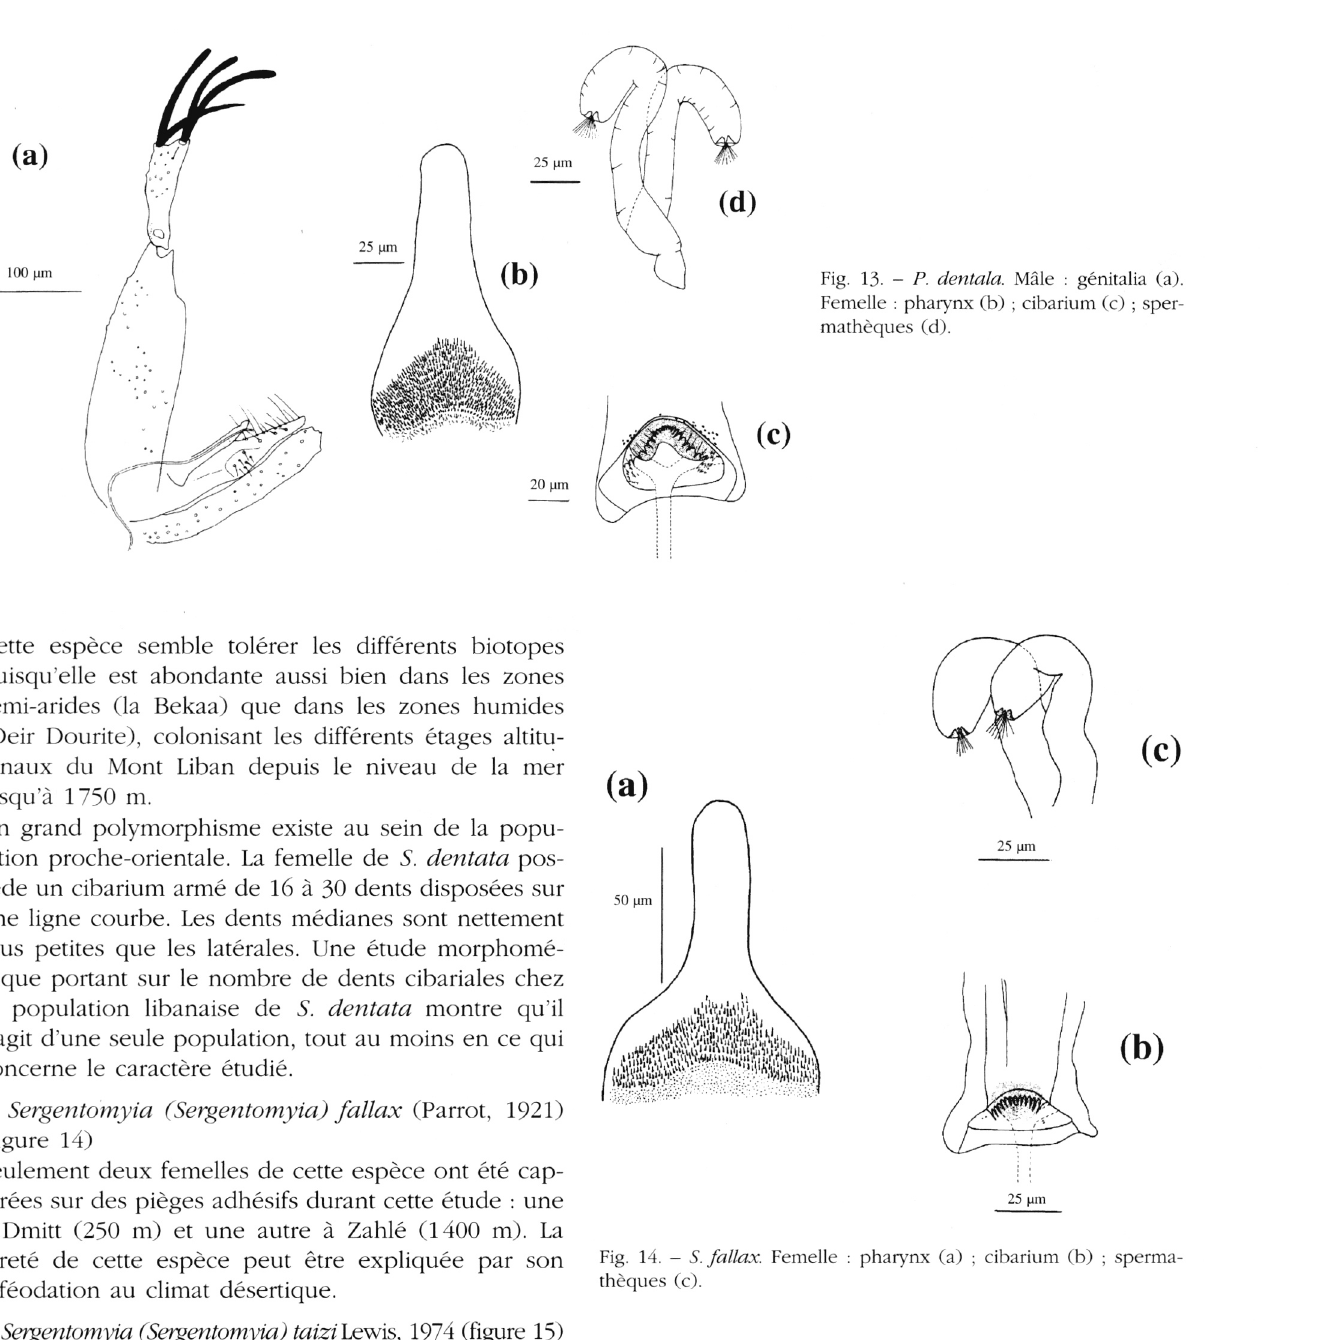
Fig. 14. - S.fallax. Femelle : pharynx (a) ; cibarium (b) ; sperma- thèques (c).